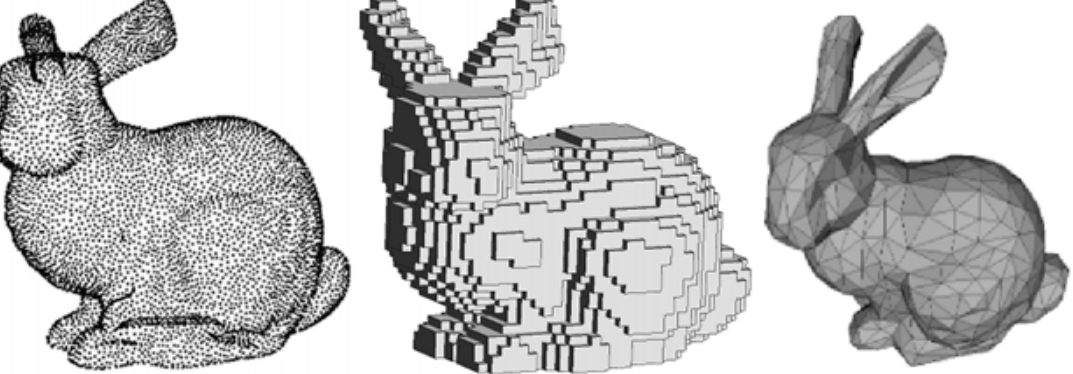
Figure 1. The 3D data forms of the Stanford bunny model: Point clouds (left), voxel (middle), and 3D triangle mesh (right).